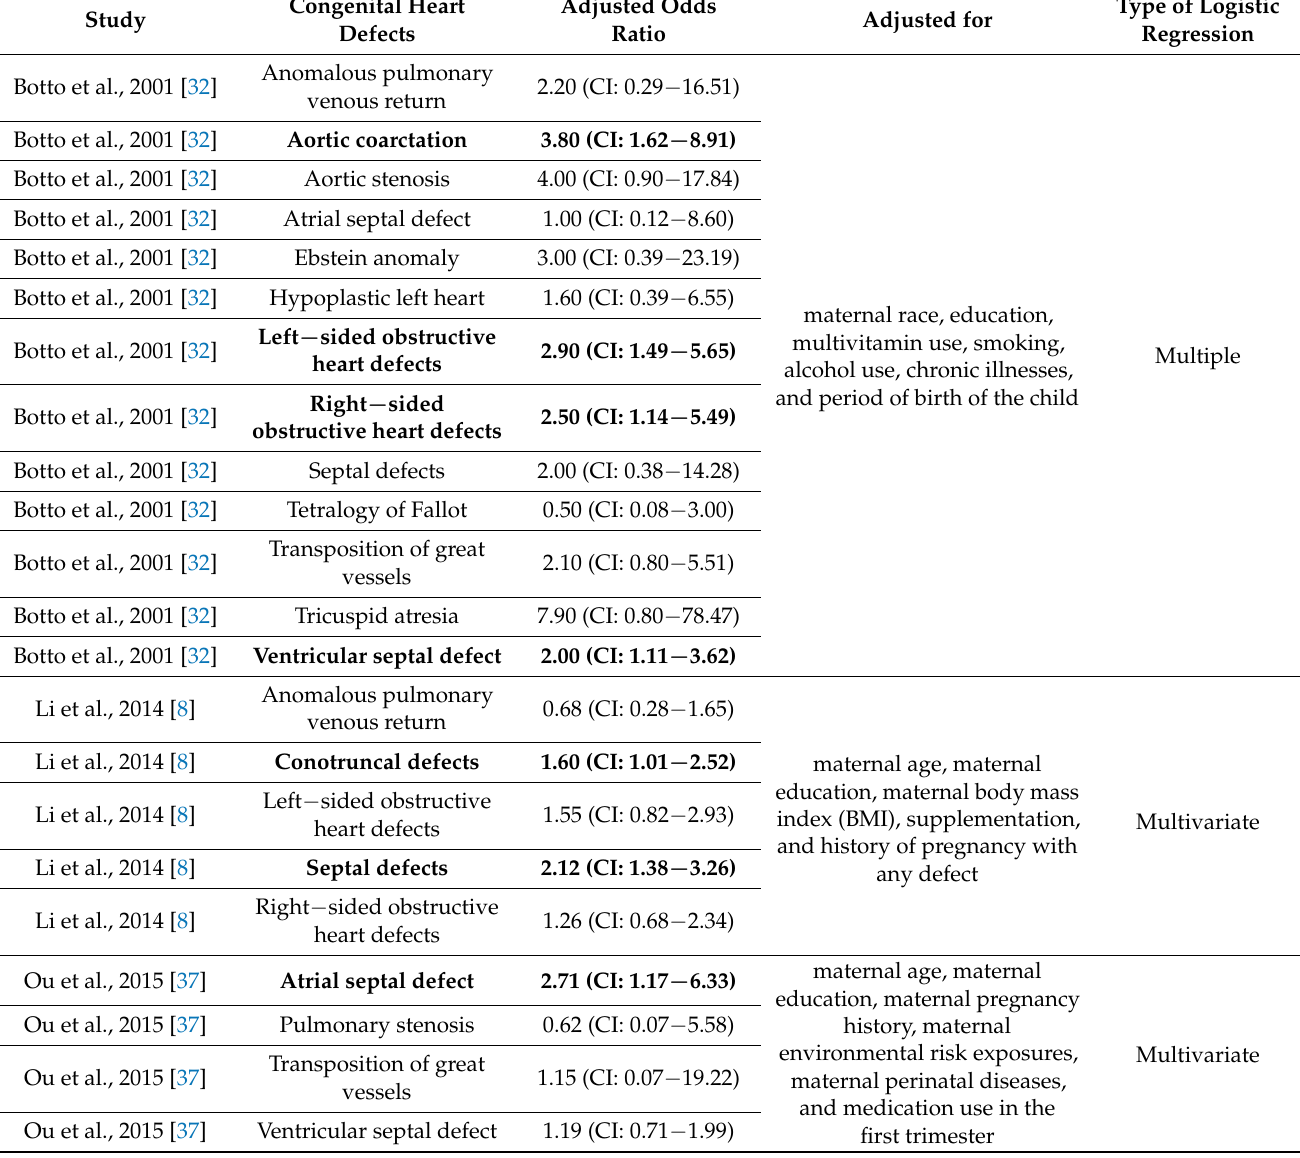
Table 3. Detailed odds ratios for developing specific congenital heart defects after influenza in the first